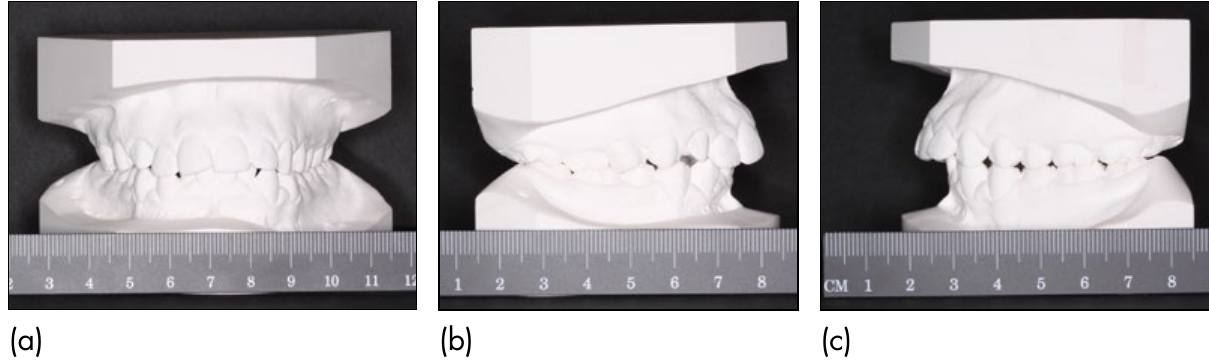
Figure 2 (a, b, c). Anterior, left and right photographs of study model (with mm ruler) in